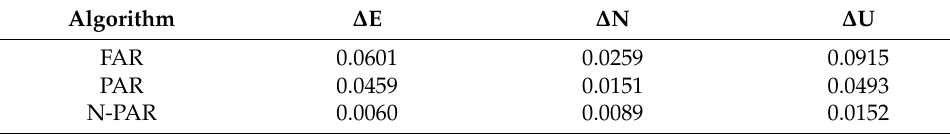
Table 3. Calculation accuracy statistics of each